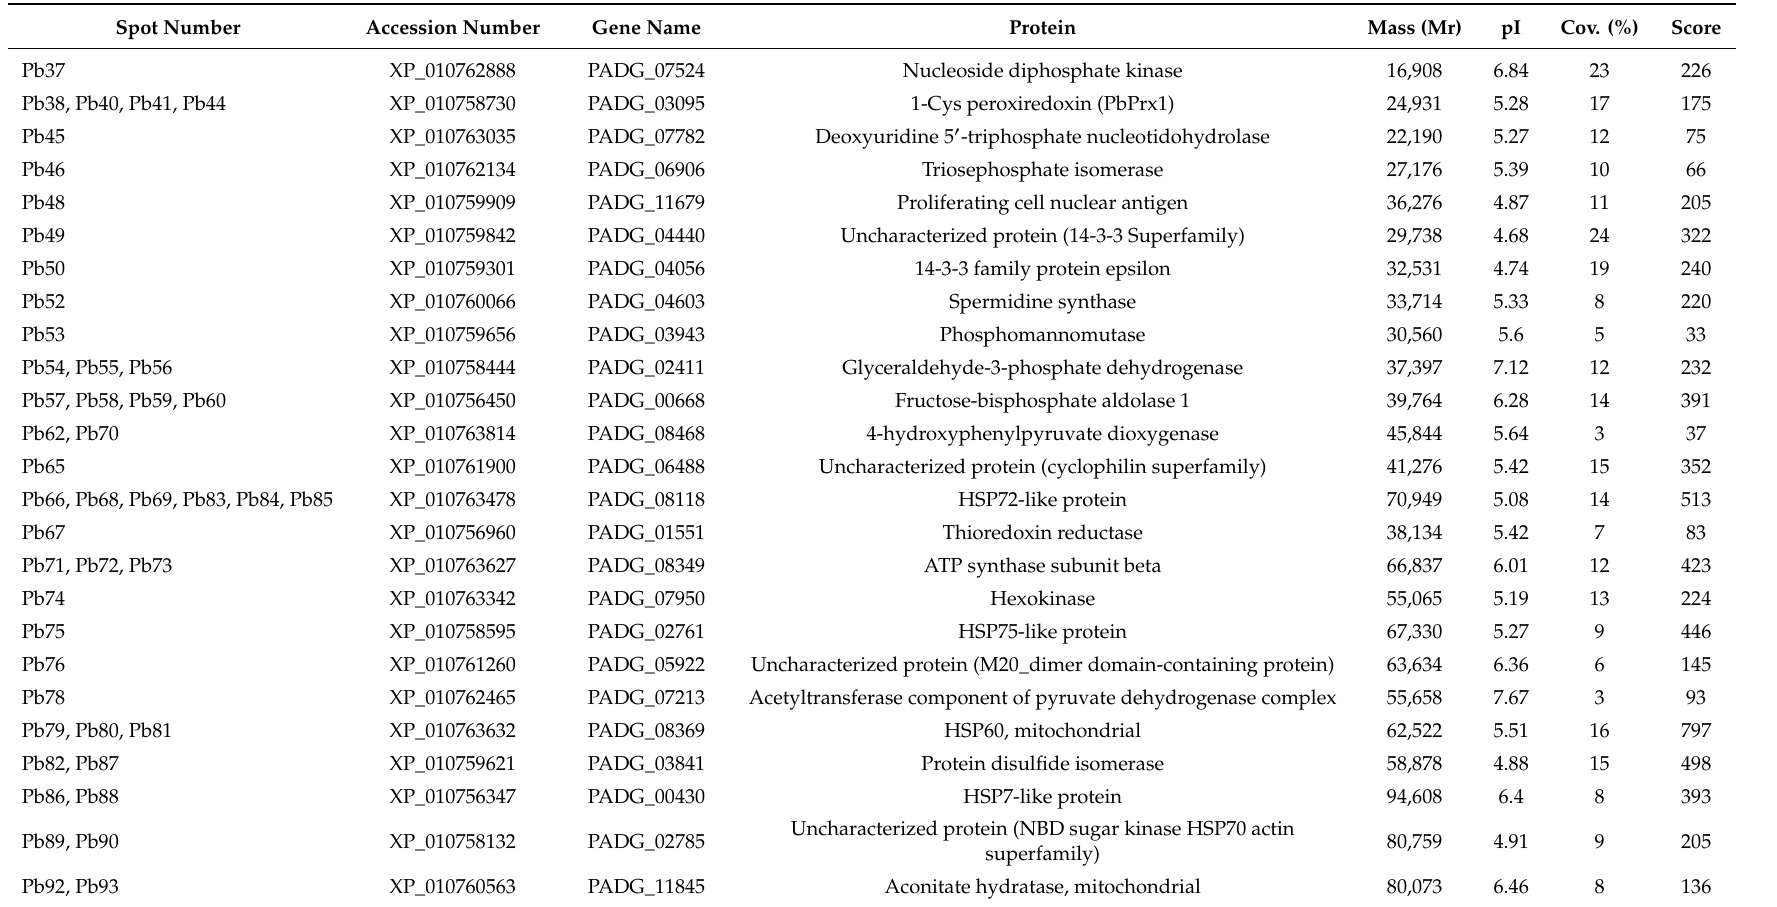
Table 2. Identification of IgG-reactive proteins recognized by sera of patients with paracoccidioidomycosis due to Paracoccidioides brasiliensis sensu stricto